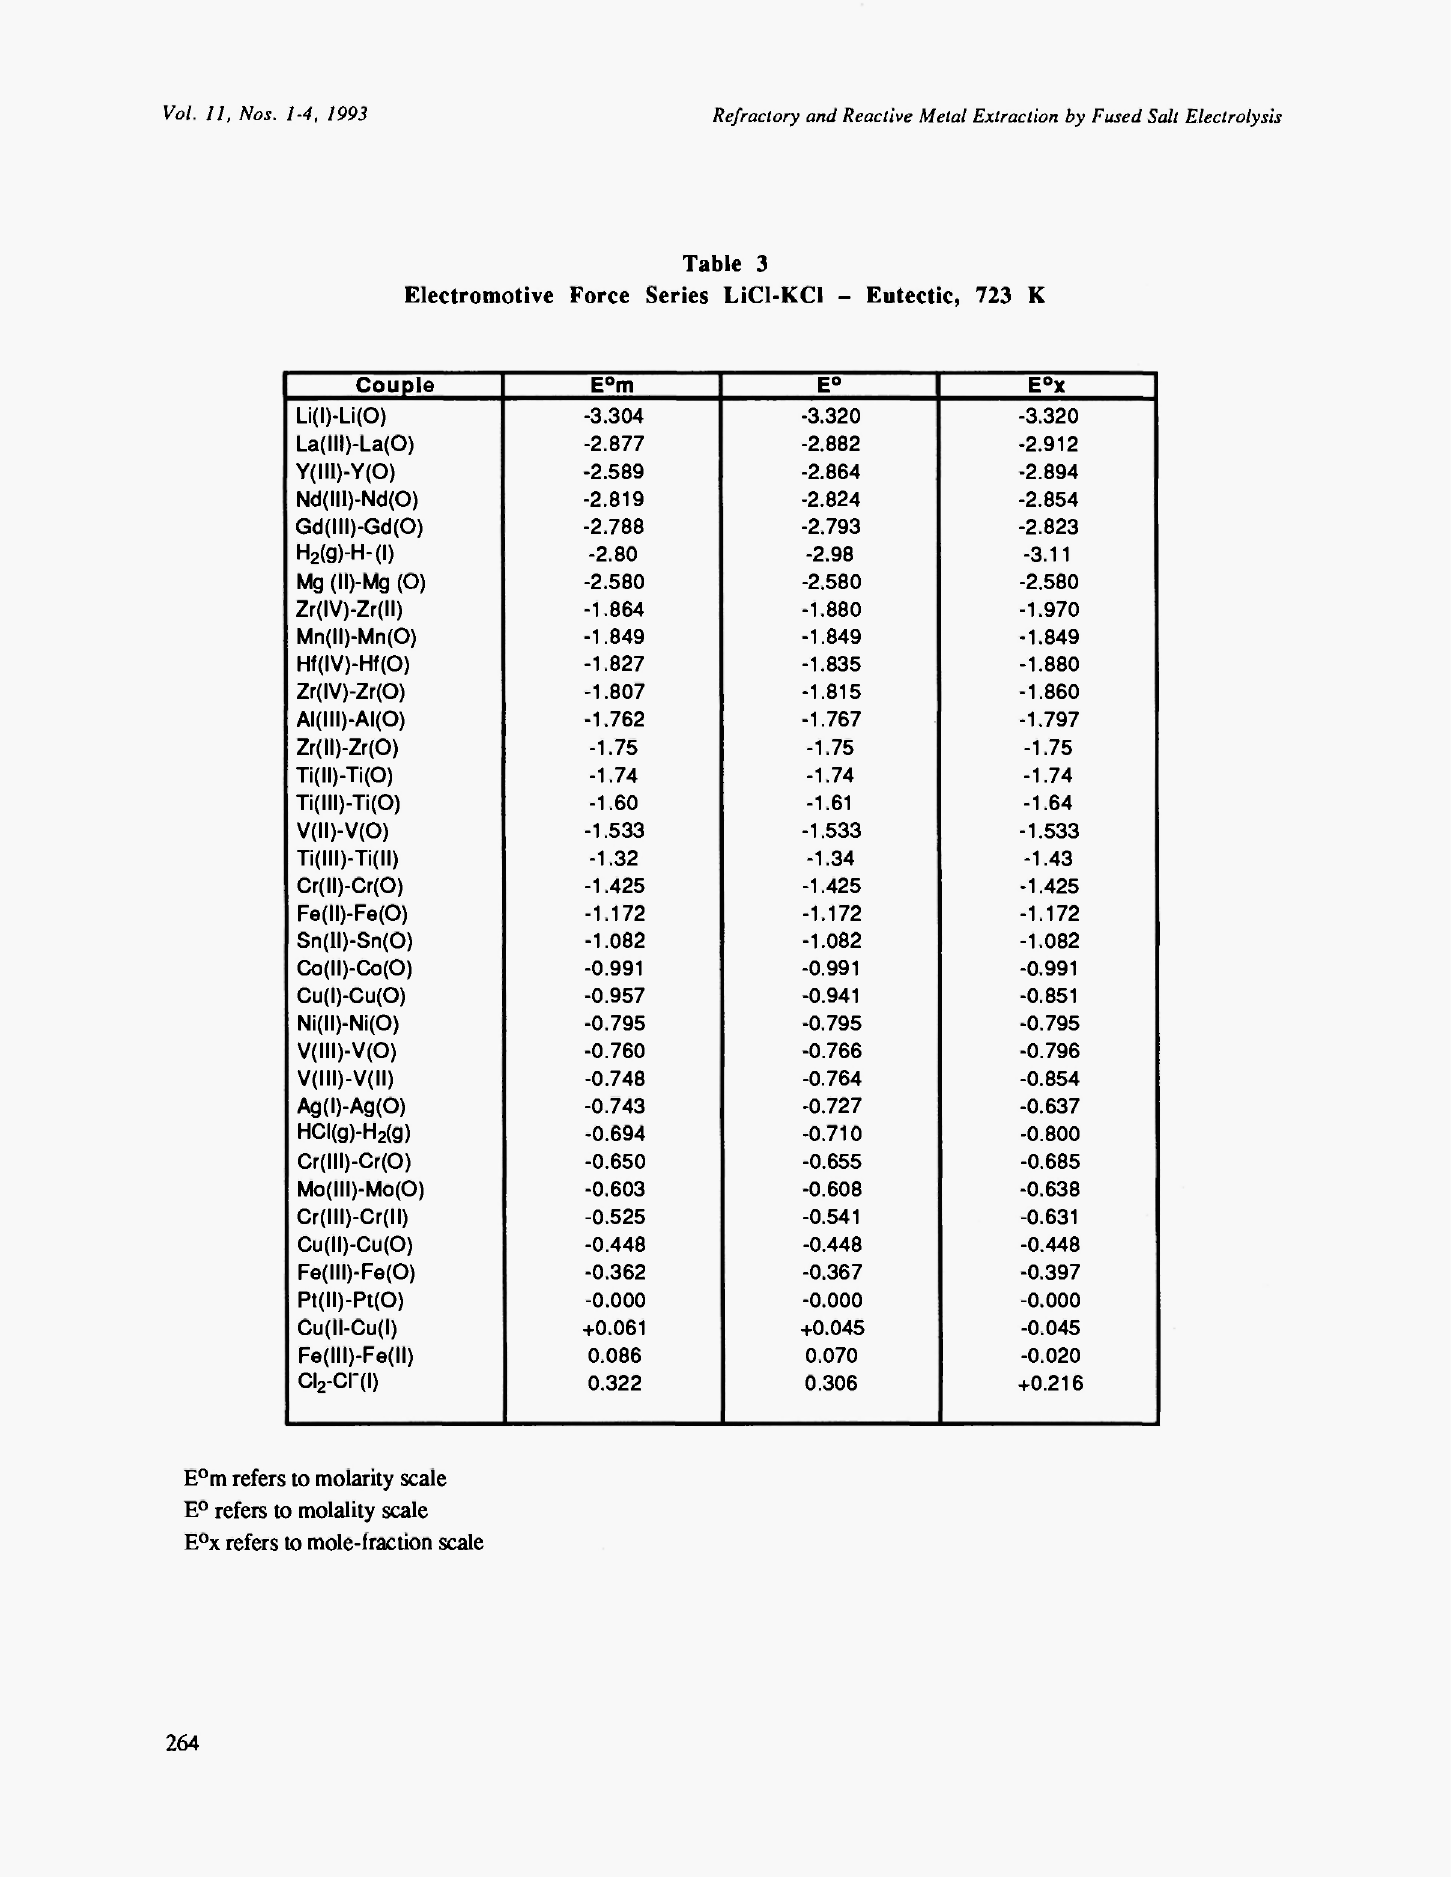
Electromotive Force Series LiCl-KCl - Eutectic, 723